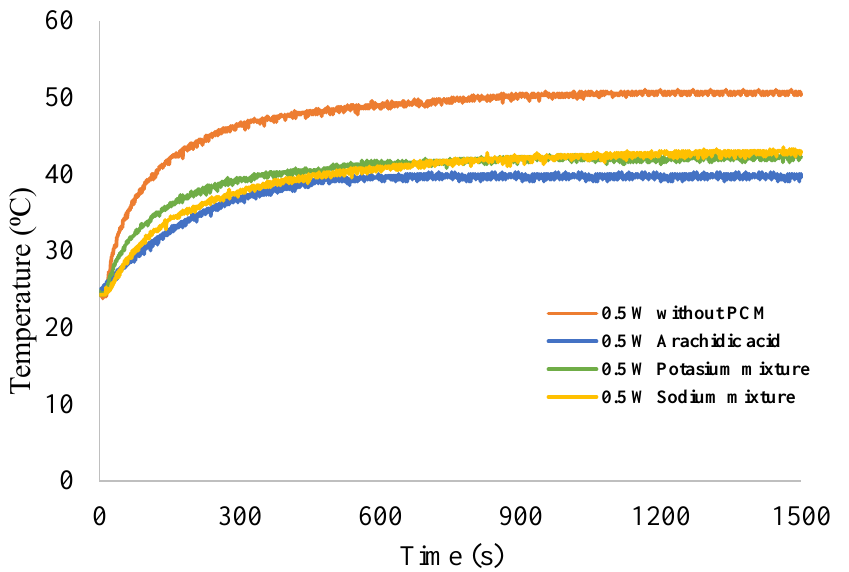
until reaching a steady-state temperature, while for the sodium mixture, the PCM melted, and the temperature decreased during melting, delaying the steady-state time by 320 s. proximately the same. For the cases of Arachidic acid and potassium mixture, they did not melt, but the steady-state temperature (59 °C) was lower than the case without PCM (72 °C).